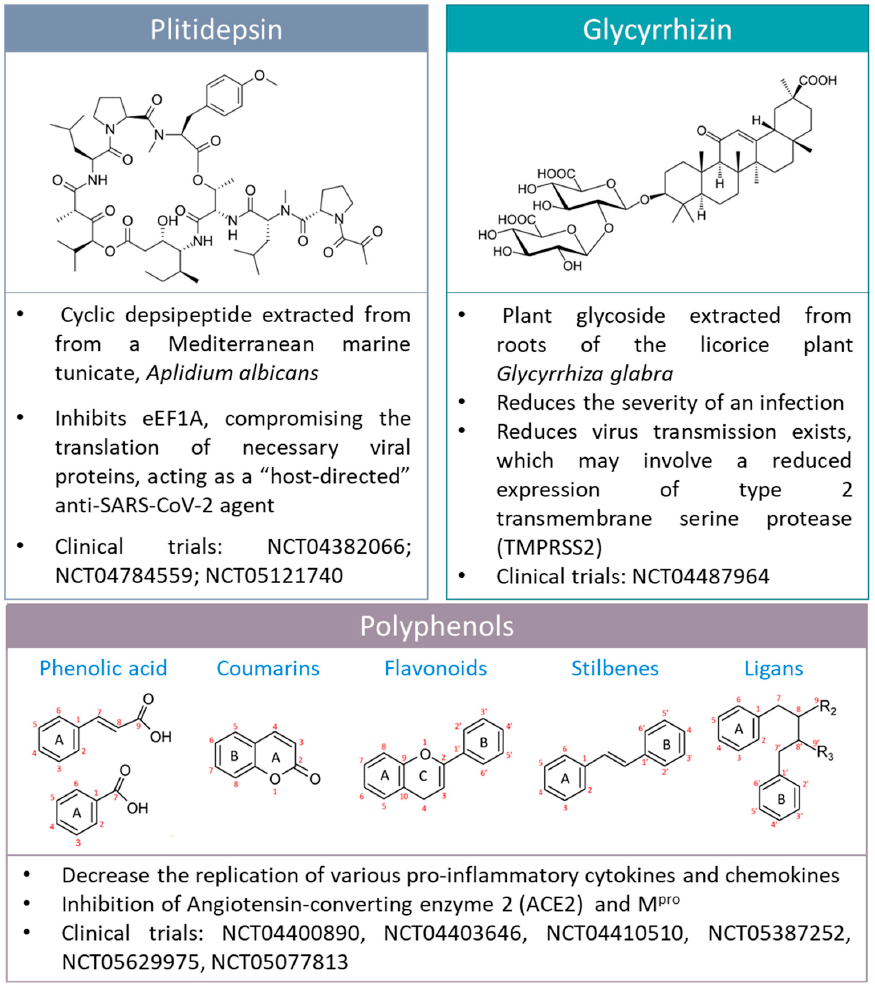
Figure 9. The chemical structure of drugs that are candidates for COVID-19 treatment, e.g., bepridil, thapsigargin, plitidepsin, glycyrrhizin, and polyphenols. Polyphenol structures were adapted from [75] under a Creative Common CC BY